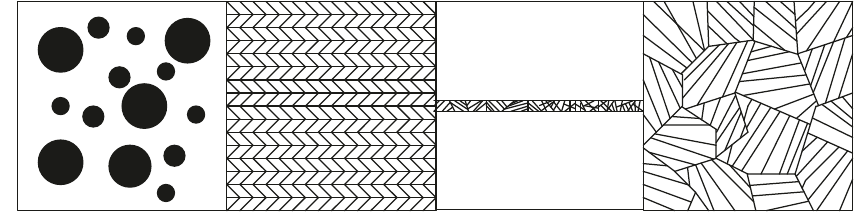
Figure 3: Basic structures of four nanomaterials.